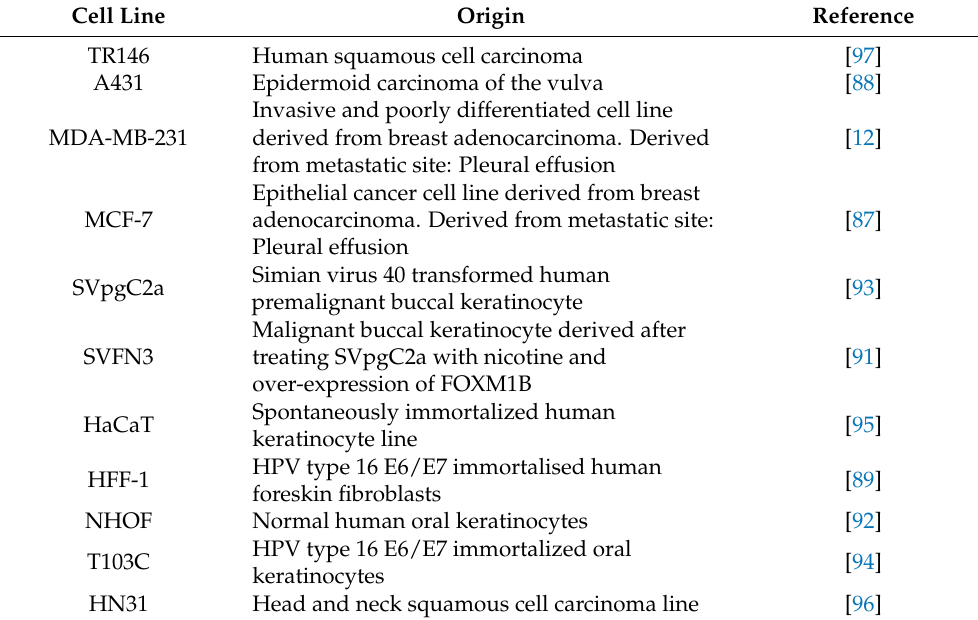
Table 1. List of cell lines used in this